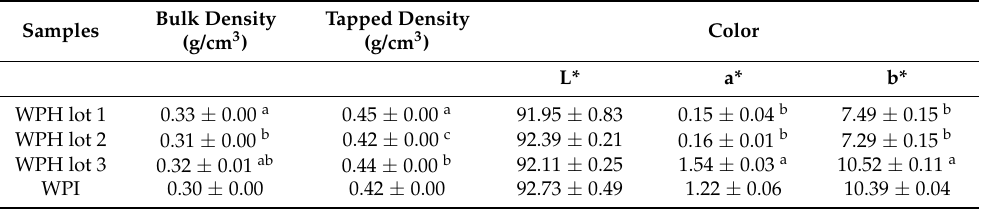
Table 3. Bulk and tapped density, color of WP1 and WPH